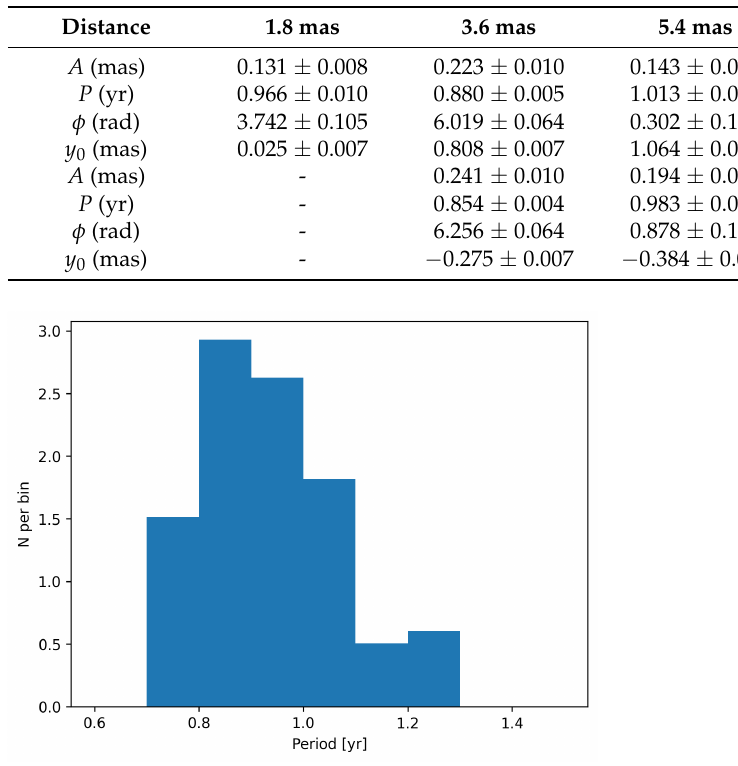
Table 1. Summary of sinusoidal fit results for the transverse motion of the M87 jet at a distance of 1.8, 3.6, 5.4, and 6.8.